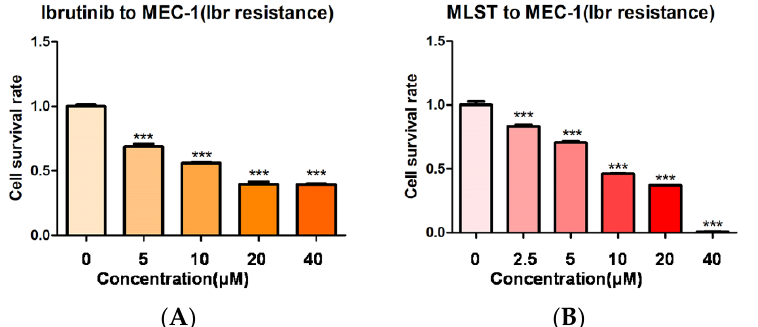
Figure 6. Effect of molidustat on ibrutinib-resistant MEC-1 cells. ( A ) Effect of different concentra- tions of ibrutinib on the survival of ibrutinib-resistant MEC-1 cells. A high concentration of 40 µ M ibrutinib still resulted in 30% survival of ibrutinib-resistant MEC-1 cells (*** means p ≤ 0.001). ( B ) Cytotoxic effects of molidustat on ibrutinib-resistant MEC-1 cells. MEC-1 cells were treated with molidustat at the indicated concentrations for 48 h. CCK-8 results showed that 40 µ M molidustat killed nearly all ibrutinib-resistant MEC-1 cells ( *** means p ≤ 0.001).